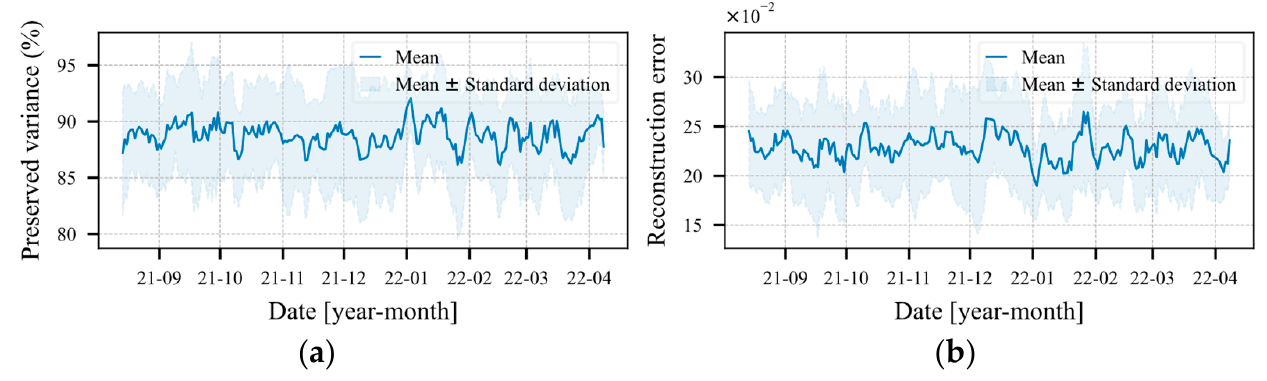
Figure 9. Average performance of the operation map regarding the five transformers. ( a ) Percentage of preserved variance and ( b ) Reconstruction error in number of standard deviations.